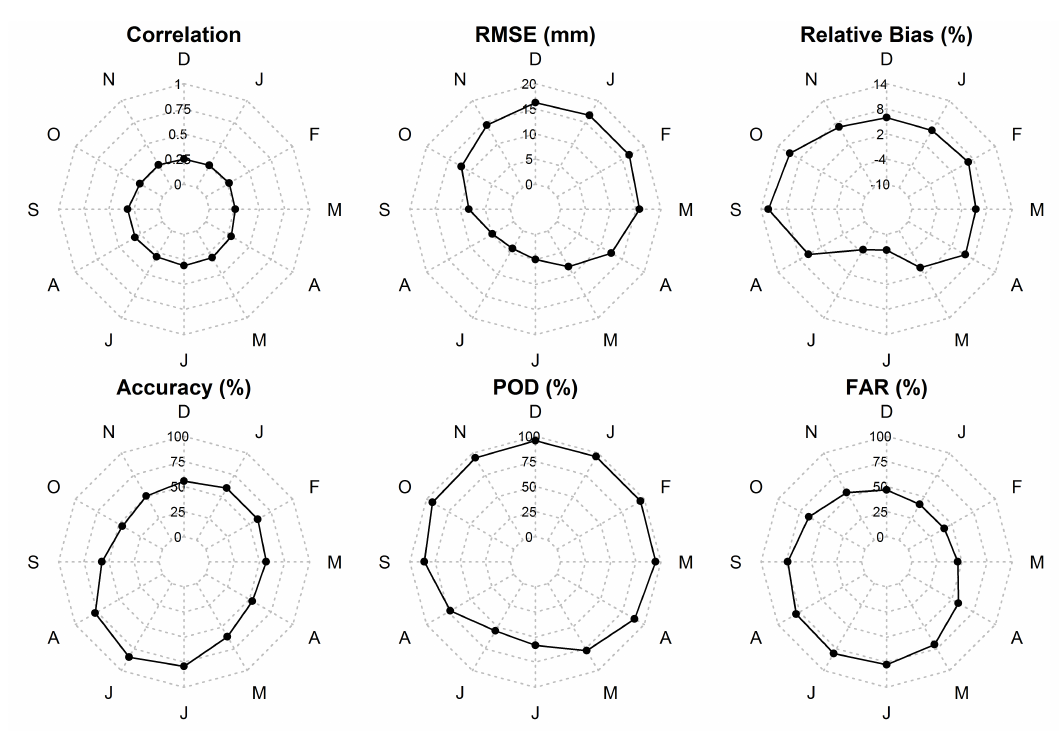
Figure 4. Daily validation statistics of PERSIANN-CDR data computed per month on 71 rain gauges located in the southern